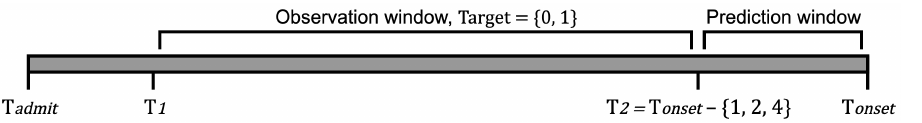
Figure 3. Diagram of our predictive tasks. The data in the observation window between T 1 and T 2 were used to predict the clinical condition occurring at time T onset . For the positive sequences, the time of onset corresponded to the time of occurrence of the clinical condition. For the negative sequences, the time of onset was randomly chosen within the